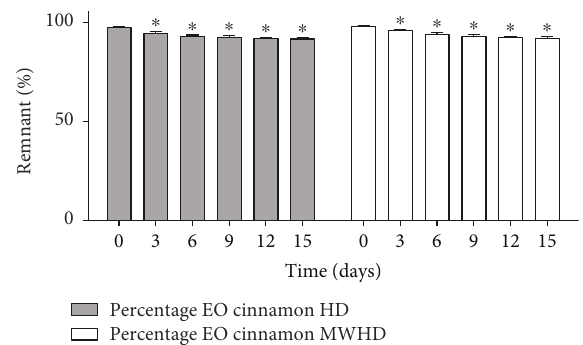
Figure 9: Remnant percentage of clove essential oil in a 15-day aging, relative to the original composition. ∗ Signi fi cant di ff erences compared to day 0 p < 0 05 .